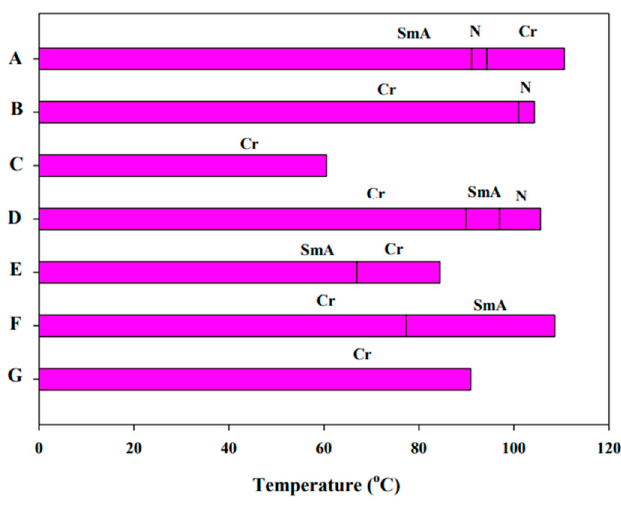
Figure 6. DSC transition of 5(a – g) . Reprinted/adapted with permission from Ref. [28]; published by Elsevier, 2020.